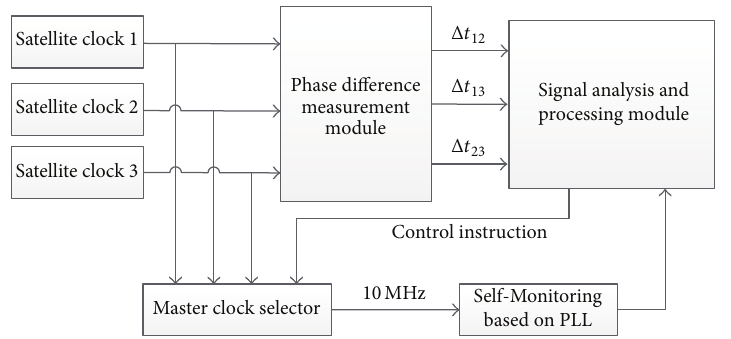
Figure 1: Global schematic diagram of Self-Monitoring Method.